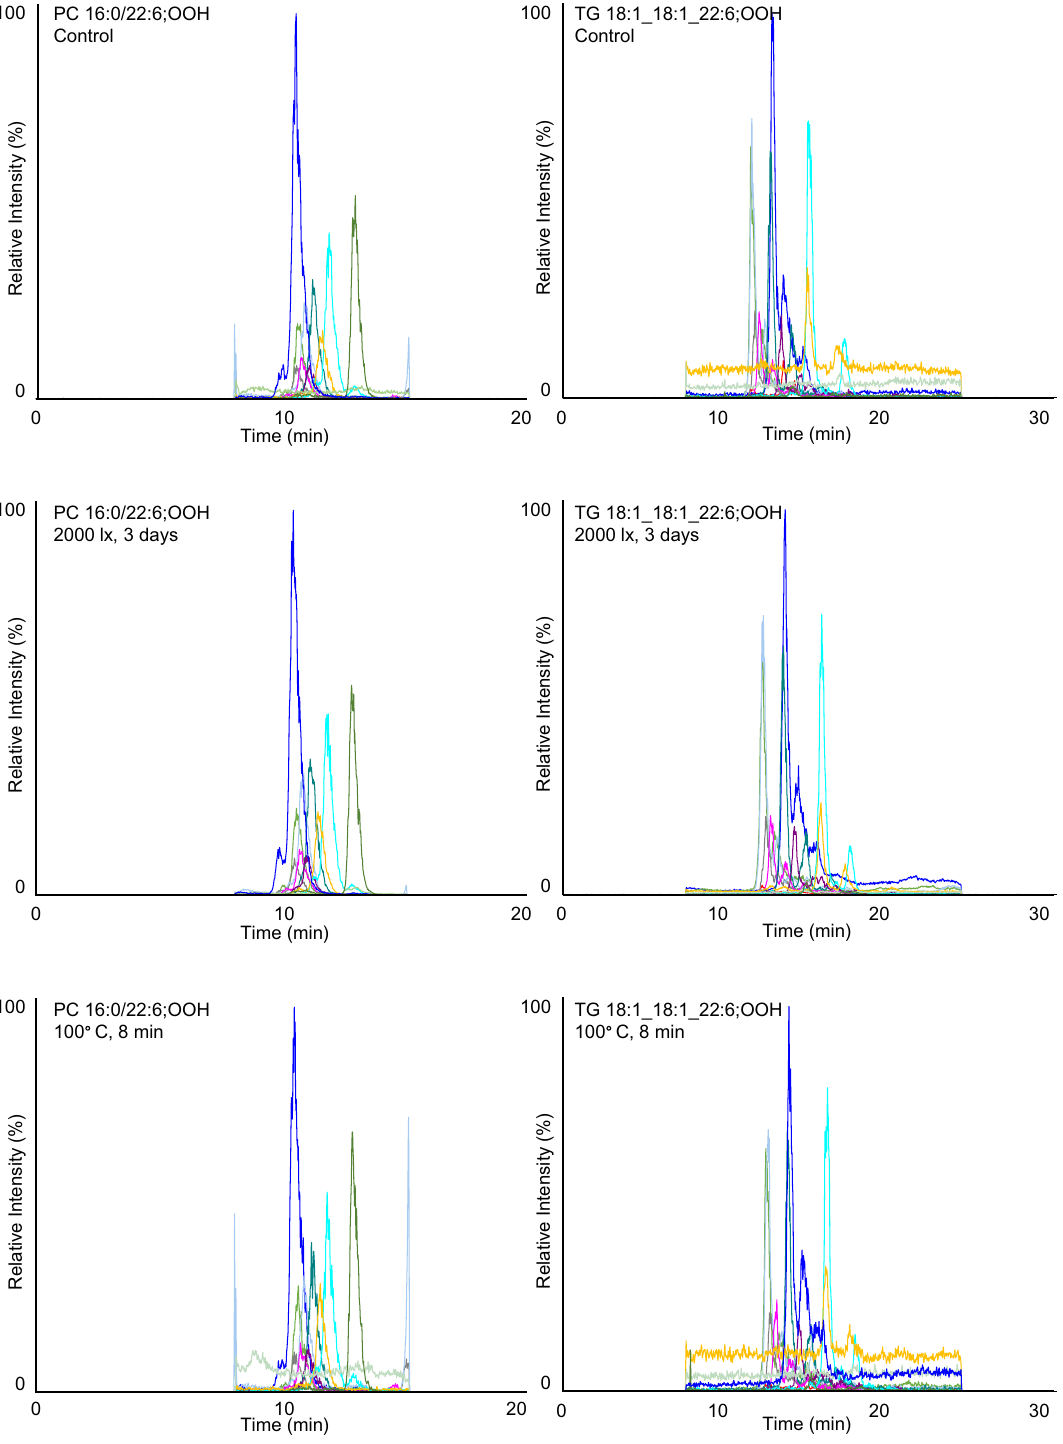
Figure 5. Typical LC–MS/MS chromatograms of PC 16:0/22:6;OOH (left) and TG 18:1_18:1_22:6;OOH (right) in